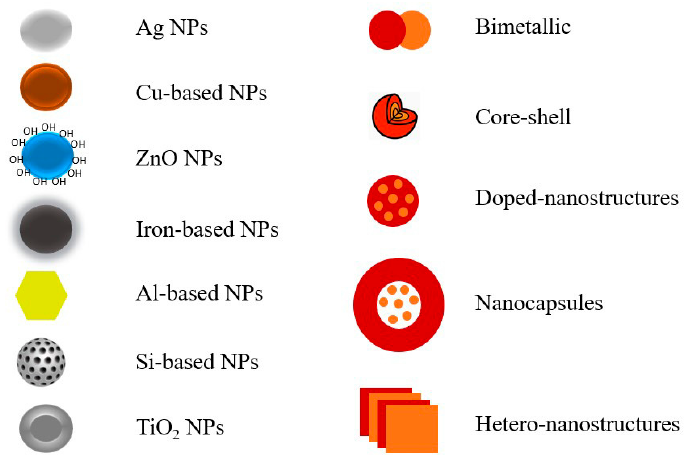
Figure 5. Schematic illustration of advanced inorganic-based nanostructures.